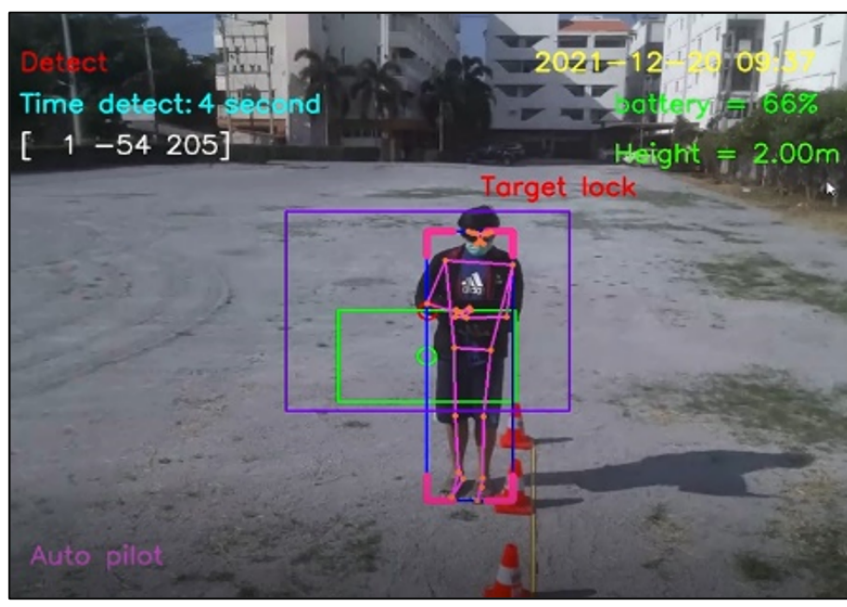
Figure 20. Exploration of light intensity for human motion detection in the morning.